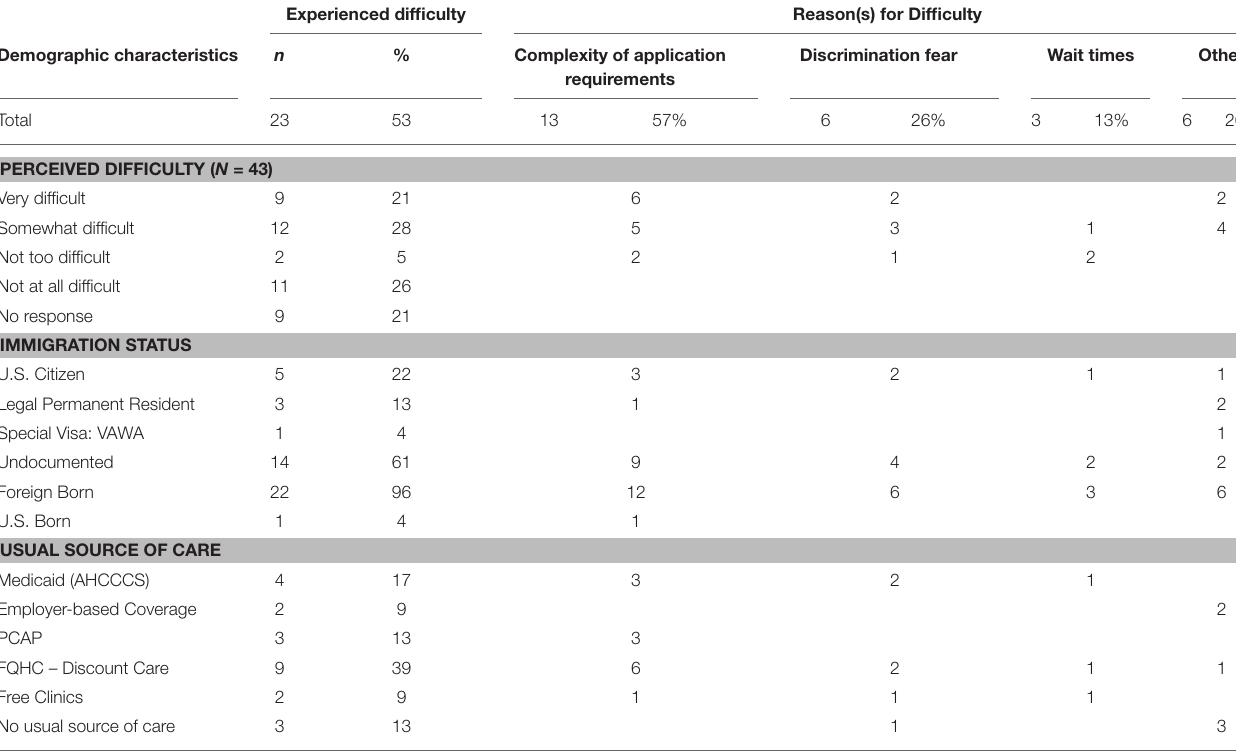
TABLE 2 | Difficulty obtaining health coverage a and selected demographic characteristics ( n =